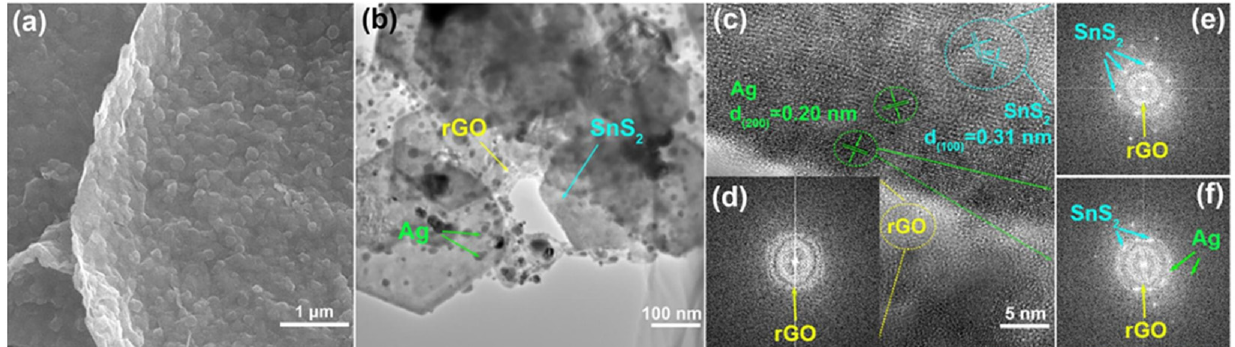
Figure 6. Morphology and microstructure analysis of rGO/SnS 2 /Ag. ( a ) SEM image and ( b ) TEM image, ( c ) HRTEM lattice fringes. ( d ) rGo diffraction patterns, ( e ) rGO/SnS2 diffraction patterns, ( f ) rGO/SnS2/Ag diffraction patterns. Reproduced with permission from Ref. [31]. Copyright 2022, Elsevier.